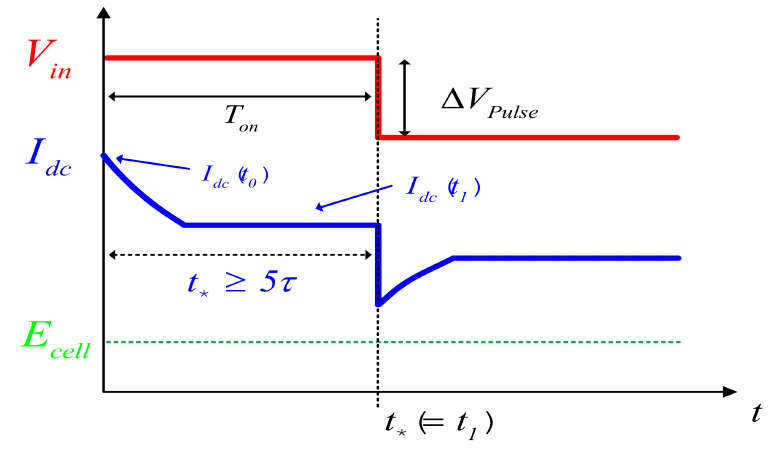
Figure 10. Steady-state current when intermittent pulse potential is applied.